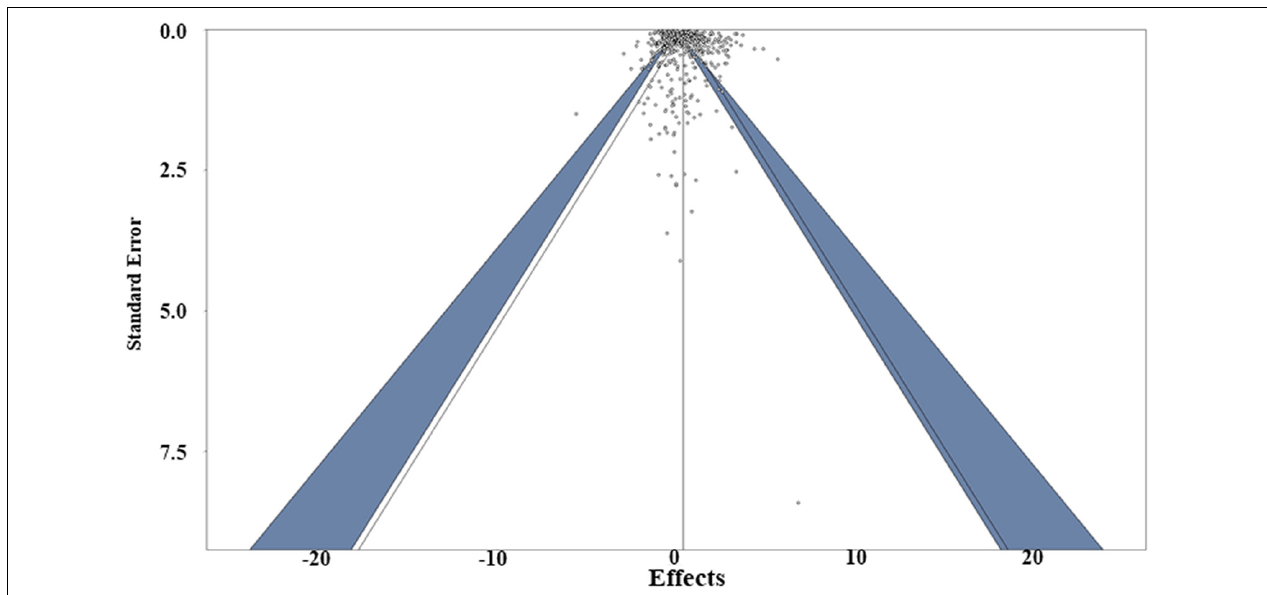
FIGURE 8 | Funnel plot of the weighted meta-analysis of the studies, including both susceptible and resistant expression data. The dark blue area means represent the 95% confidence